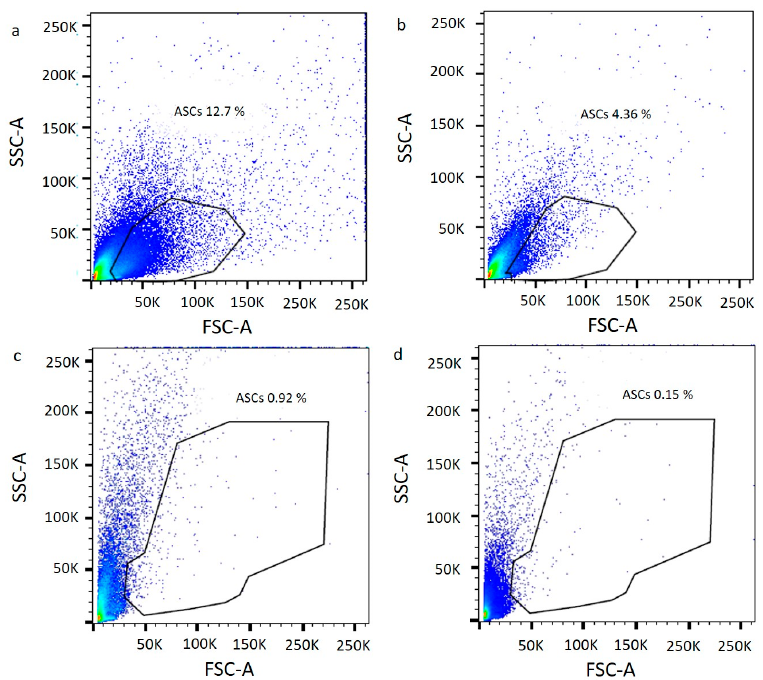
Figure 5. Cytograms of enzymatic digestion ( a , thigh; b , abdomen) and Rigenera ® product ( c , thigh; d , abdomen) at passage 0. Mesenchymal-like cells was selected based on Forward Scatter (FSC) and Side Scatter (SSC) information.